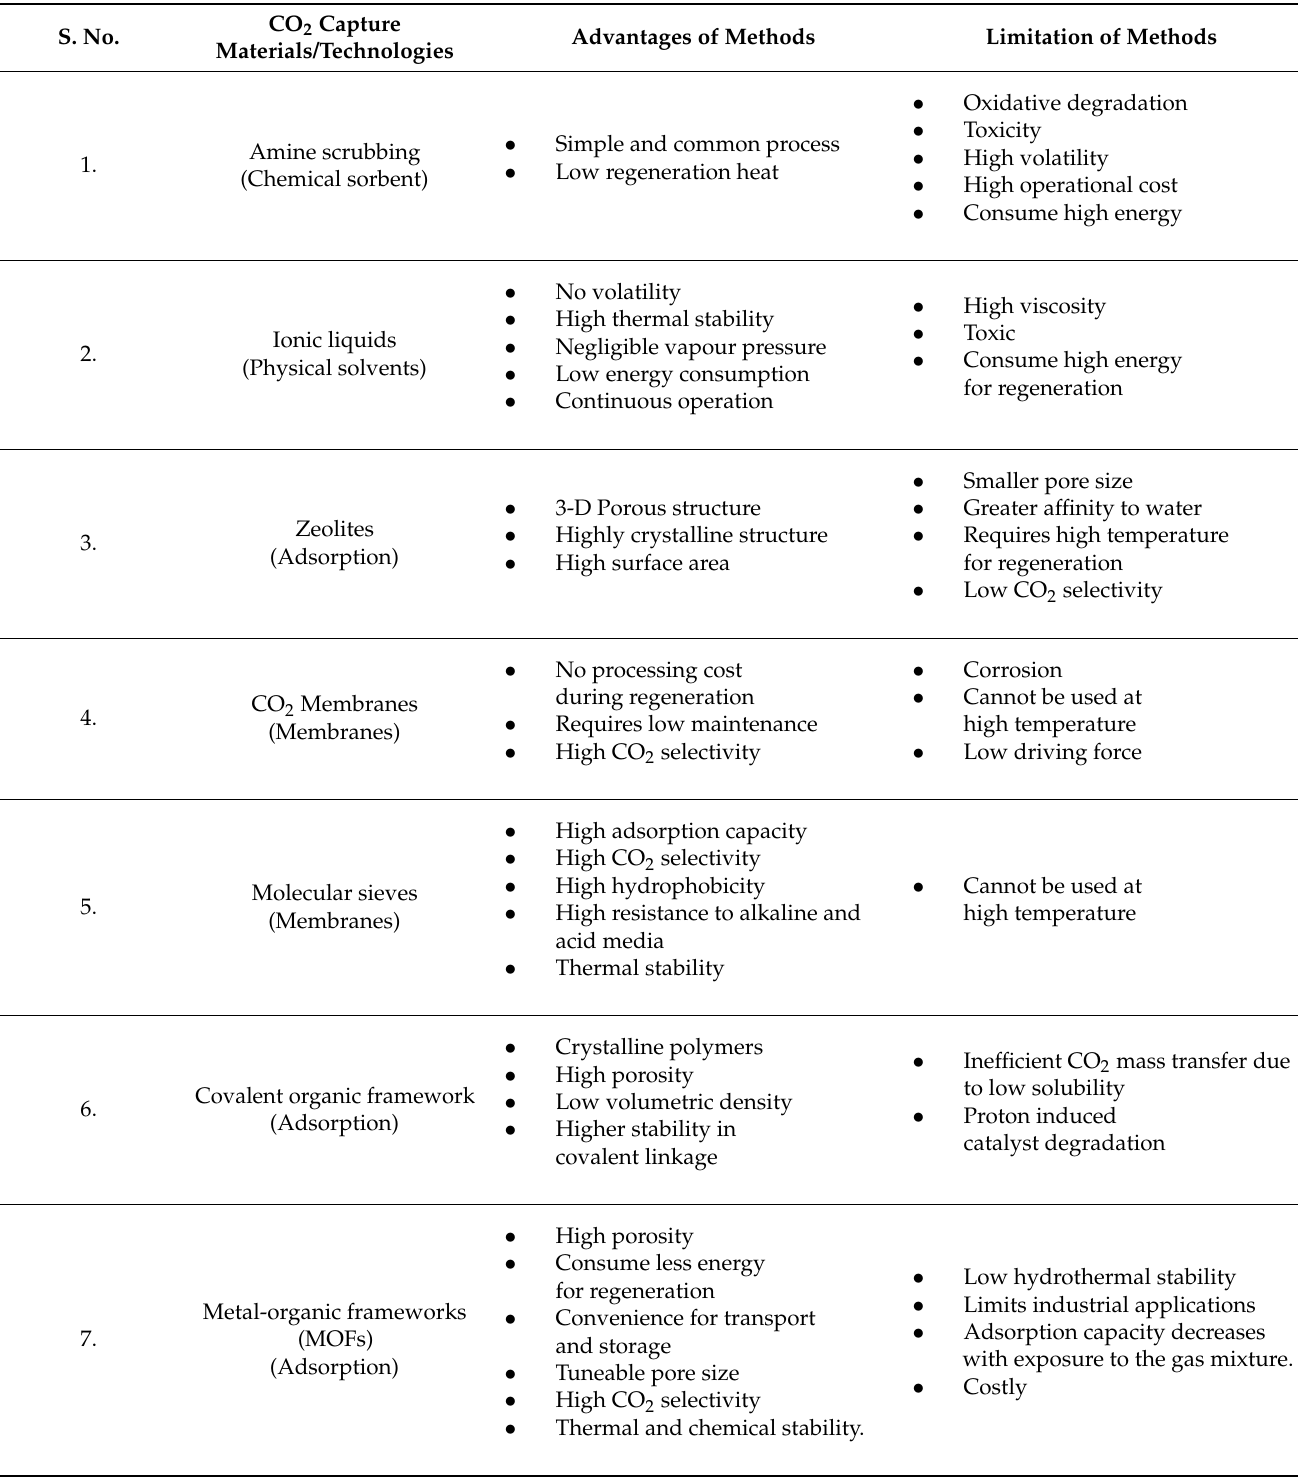
Table 1. CO 2 -capture materials/technologies with their advantages and disadvantages. S.